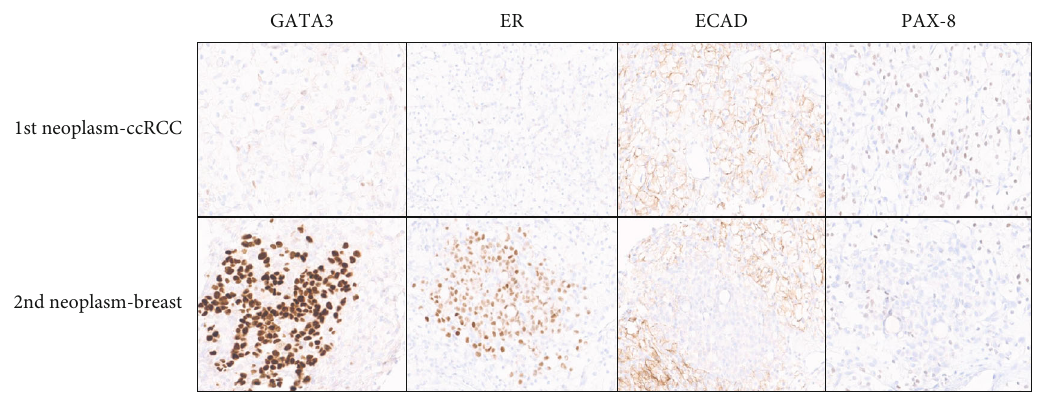
Figure 4: A panel of immunohistochemical stains performed supports the morphologic impression of two distinct neoplasms — ccRCC and metastatic lobular breast carcinoma. The neoplastic cells of the ccRCC are negative for GATA3 and ER, but immunoreactive for ECAD and PAX-8. The neoplastic cells of the metastatic lobular breast carcinoma are immunoreactive for GATA3 and ER, but negative for ECAD and PAX-8. Immunostains for CK7, CD10, and RCC antigen are not